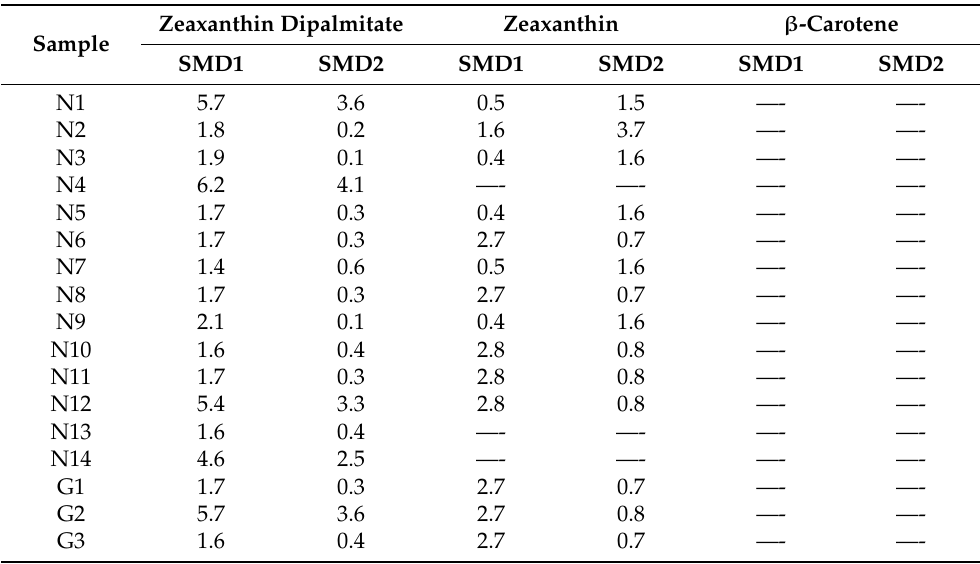
Figure 2. HCA dendrogram of 34 batches of LB. The abscissa indicated the squared euclidean distance, whereas the ordinate expressed the sample numbers. Table 7. The SMD between different QAMS methods with ESM